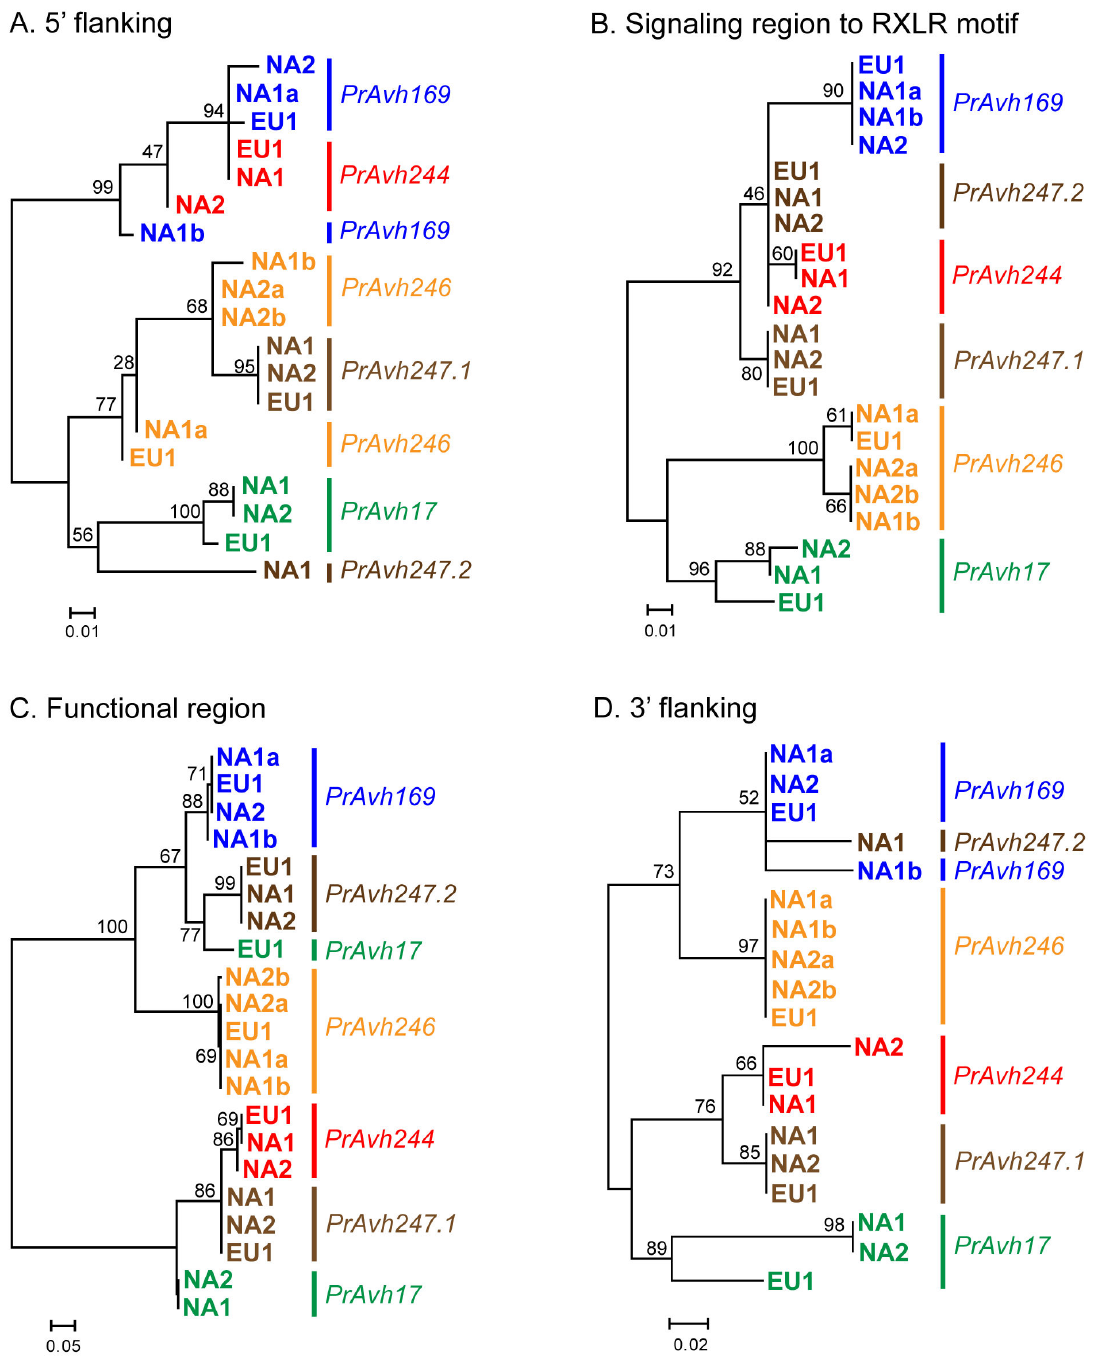
Figure 5. Recombination breakpoints occur between key gene regions in a P. ramorum RXLR effector family. Maximum likelihood trees were constructed for different fragments of genes exhibiting recombination among paralogs and show the changing evolutionary relationships among both genes and alleles between gene regions. Approximate recombination breakpoints were inferred using RDP and indels were removed. The sequences between inferred recombination breakpoints used for phylogenetic analysis were A. 5’ flanking sequences (201 bp), B. the targeting region (157 bp), from the start codon to RXLR motif, C. the functional (C-terminal) region (149 bp), and D. 3’ flanking sequences (70 bp). A short region around the DEER motif is not shown. Branch support is given as a percentage of 500 bootstrap samples. The branch lengths are drawn to scale and measured in the number of substitutions per site. doi: